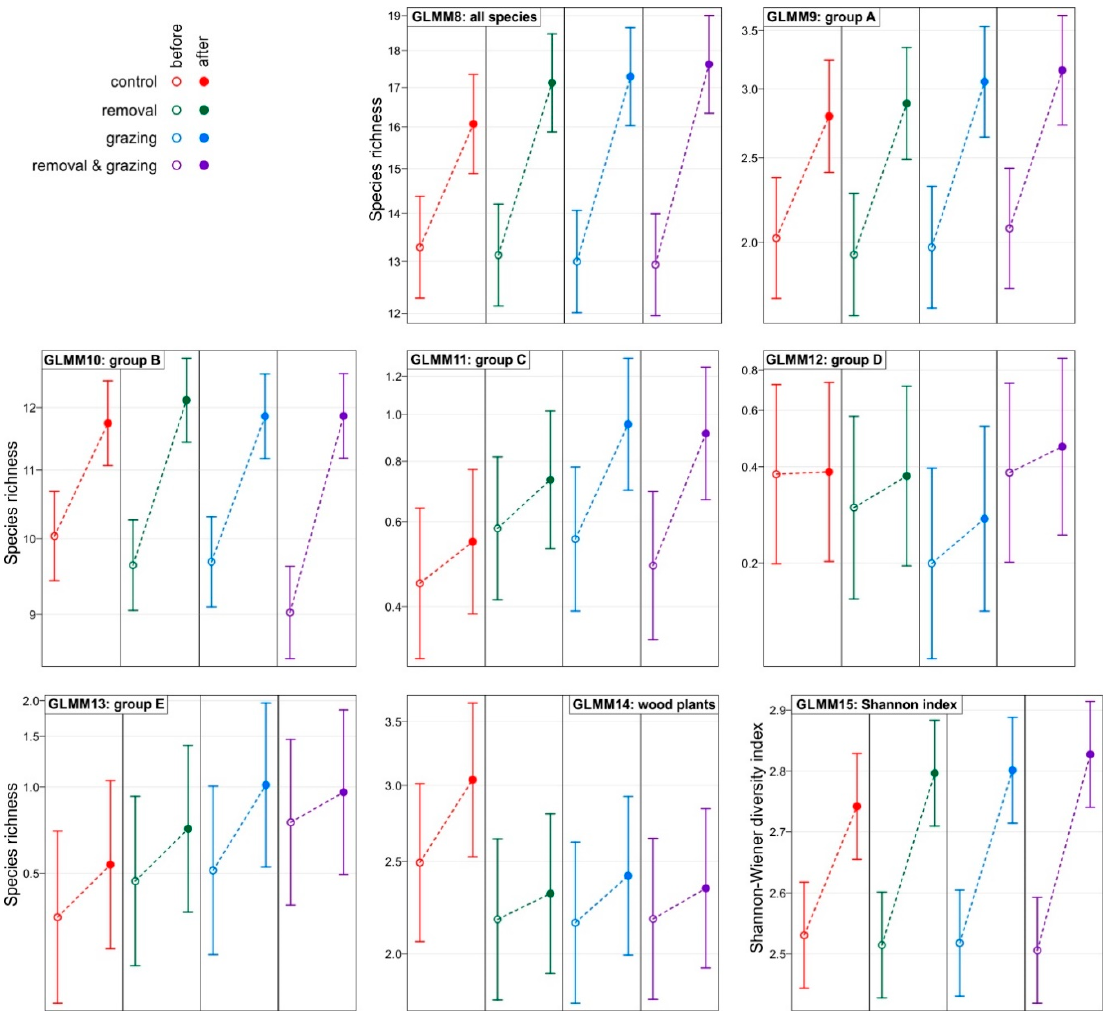
Figure 3. Species richness and Shannon-Wiener diversity index (and 95% confidence intervals) of all